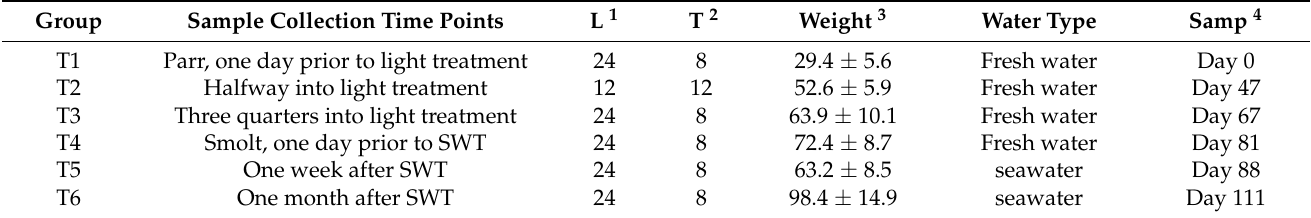
Table 7. Time points and conditions where gill samples were collected.